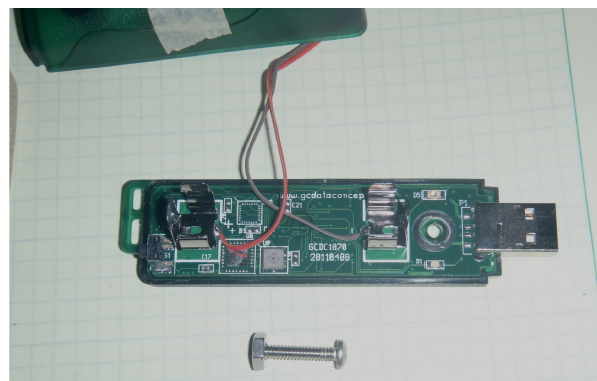
Fig. 1. Datalogger with the casing partly removed. The USB con- nector is at right, the AA battery terminals are visible at right and left (with user-supplied wires soldered there to provide an alterna- tive power supply in this application). The pressure transducer is the silver square at the lower edge of the board. The memory, micro- controller and other components are on the other side of the circuit